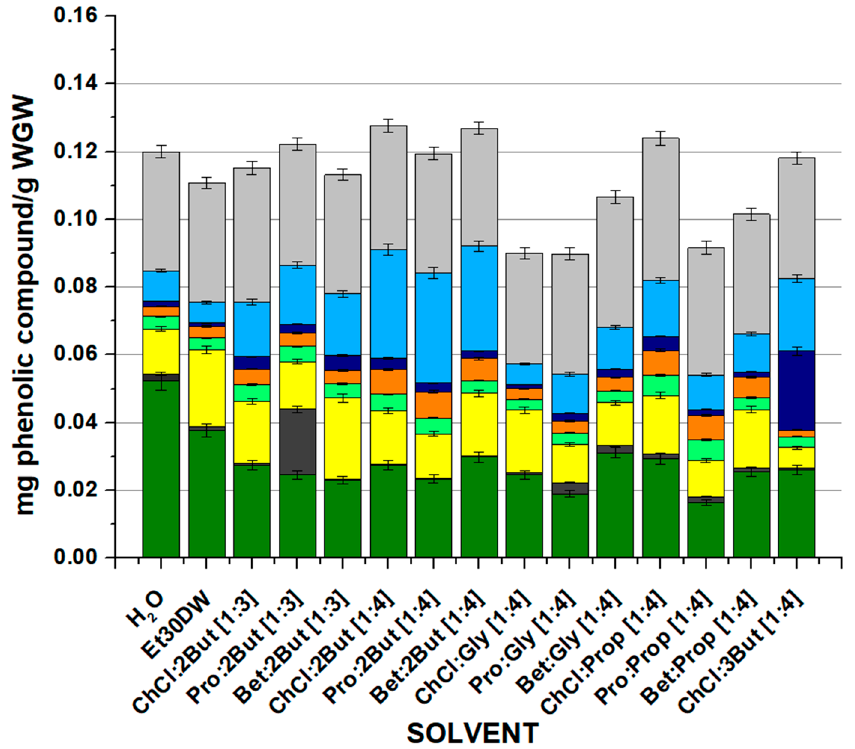
Figure 3. Mass (mg) of specifically each of the phenolic compounds quantified by HPLC after the conventional extraction process with each evaluated solvent. Results are expressed as mean values (mg phenolic compounds/g WGW) ± RSD (%). OSE conditions: 100 min at 900 rpm, 60 °C, and 1:10 F:S ratio.